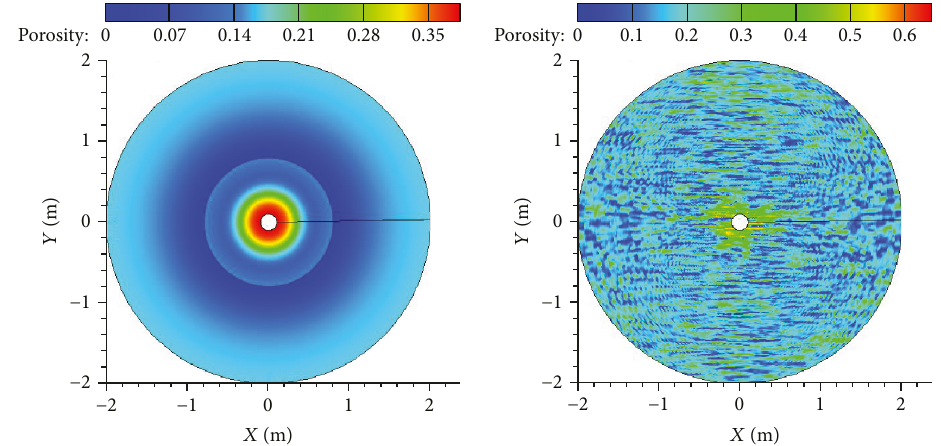
Figure 6: Porosity distribution after acidizing for homogeneous and heterogeneous initial